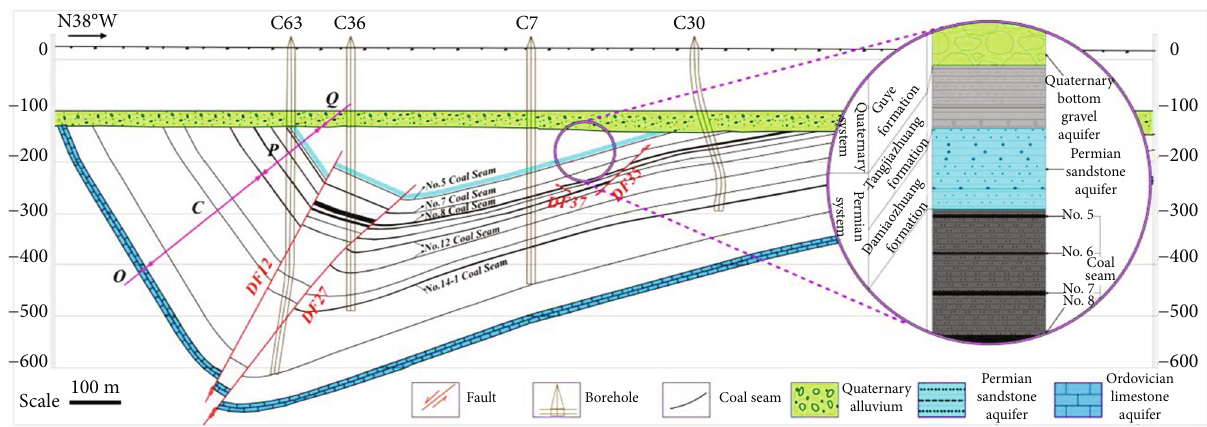
Figure 2: 2-2 ′ geological pro fi le of the study